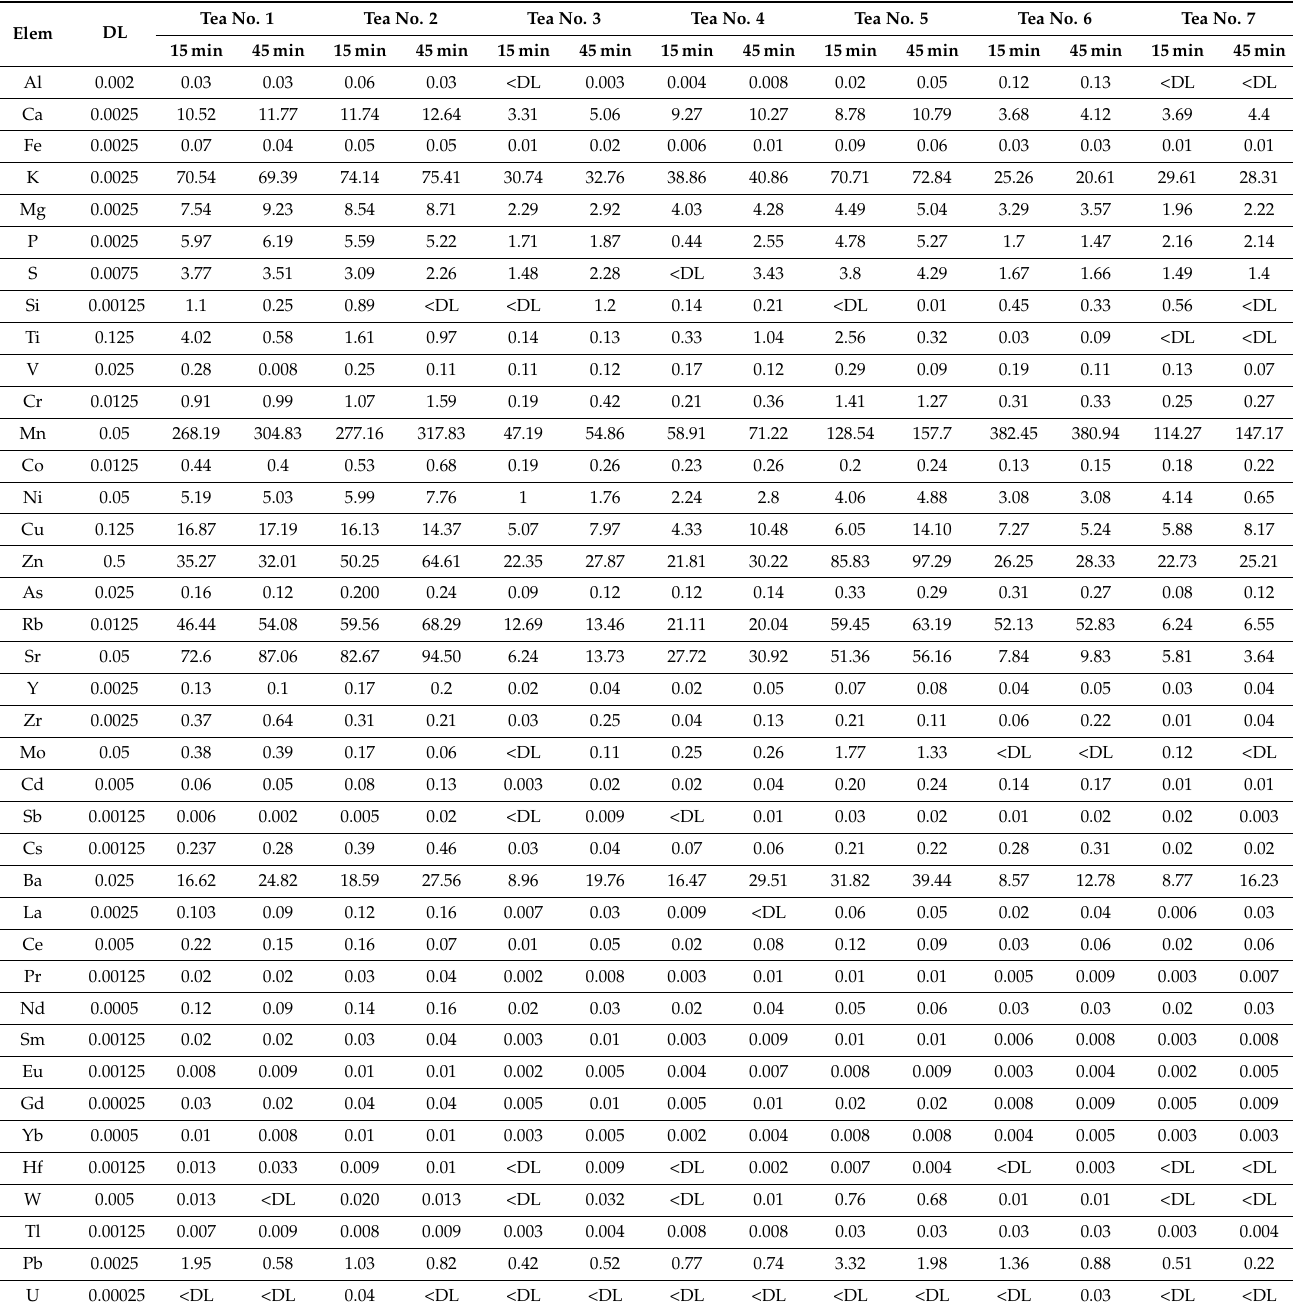
Table 5. Elemental content in a 250 mL infusion (Al, Ca, Fe, K, Mg, P, S, Si–in mg, the rest–in µ